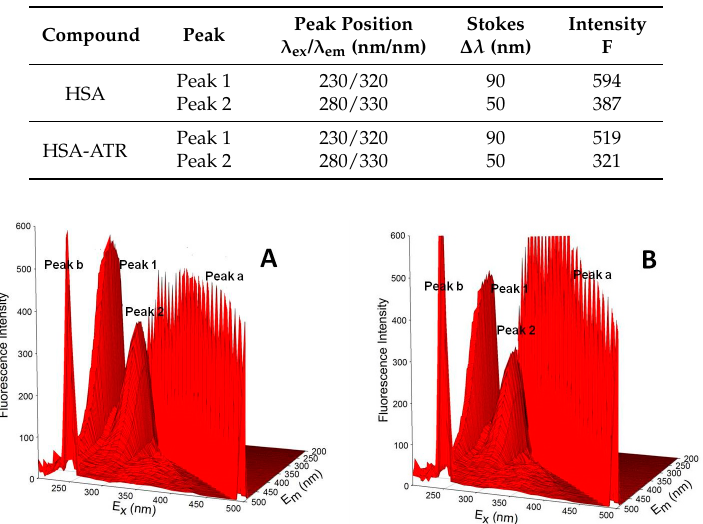
Table 6. Intensity ratios of peaks 1 and 2.